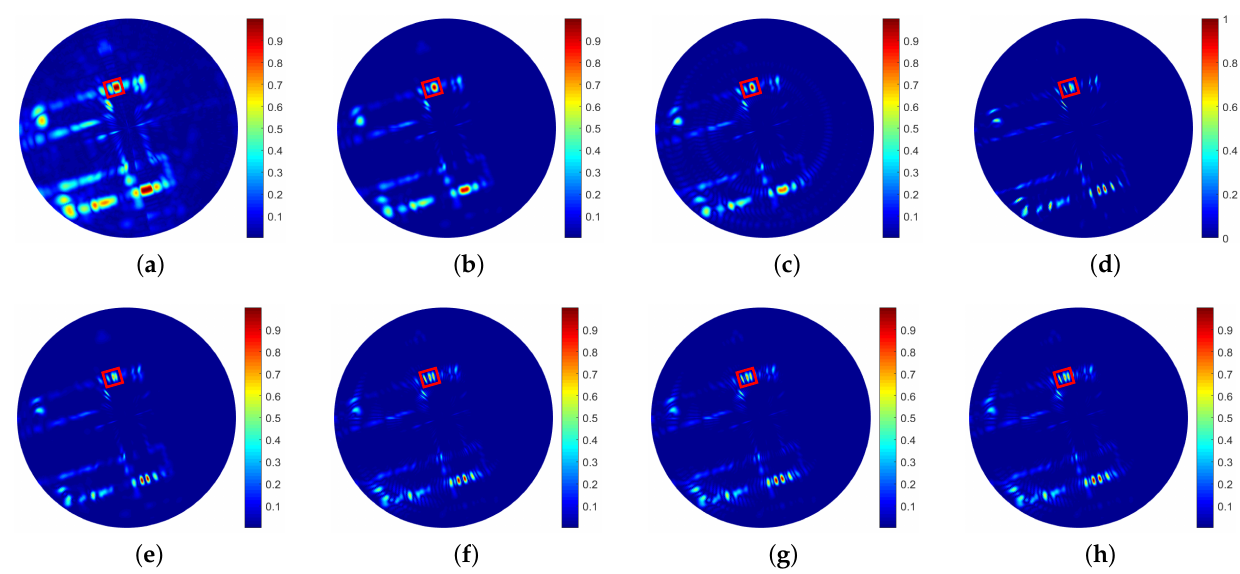
Figure 10. Processed results of roof data. ( a ) Real beam echo, ( b ) Result of TREGU, ( c ) Result of TSVD, ( d ) Result of RL, ( e ) Result of IAA, ( f ) Result of SBA, ( g ) Result of FSBA, ( h ) Result of SFSBA.